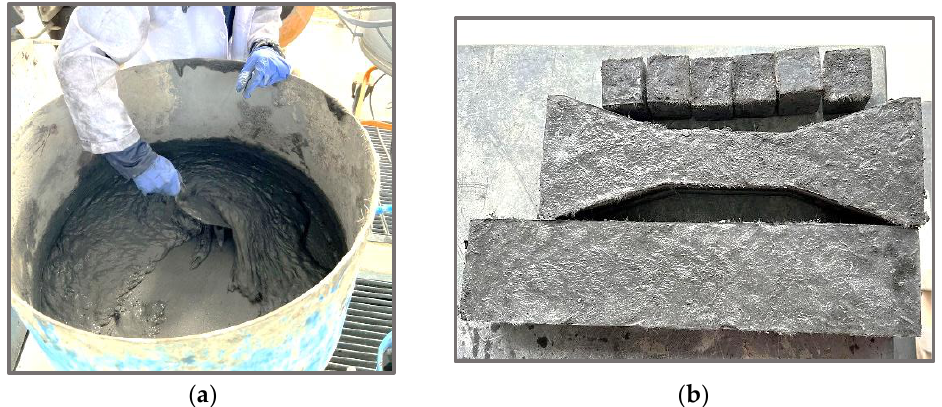
Figure 3. ( a ) Freshly mixed POFA-ECC. ( b ) POFA-ECC test samples before curing.